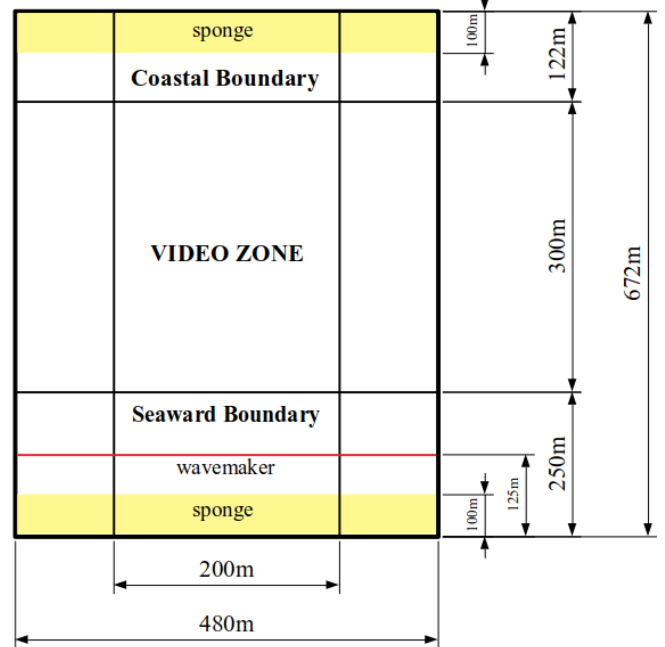
Figure A1. Domain used in the FUNWAVE simulations, where the study region is called video